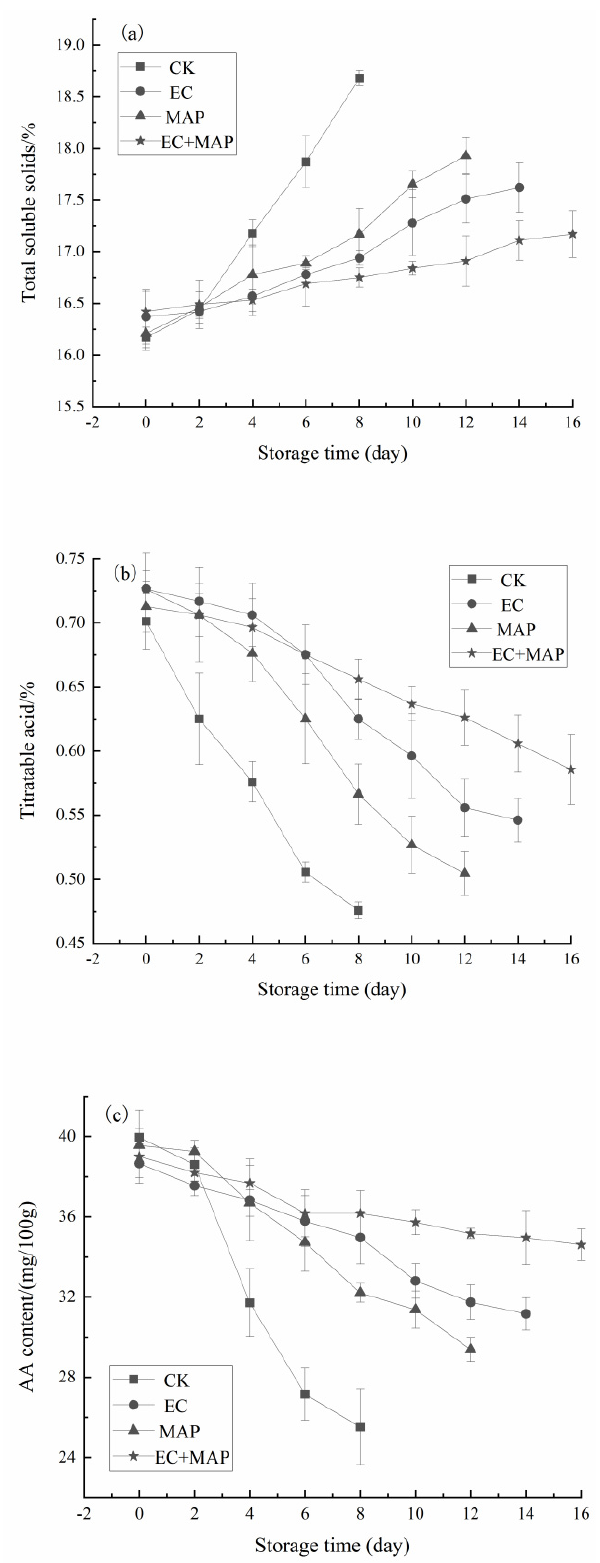
Figure 2. Effect of different treatments on TSS ( a ), TA ( b ) and AA ( c ) of fresh-cut pineapples during